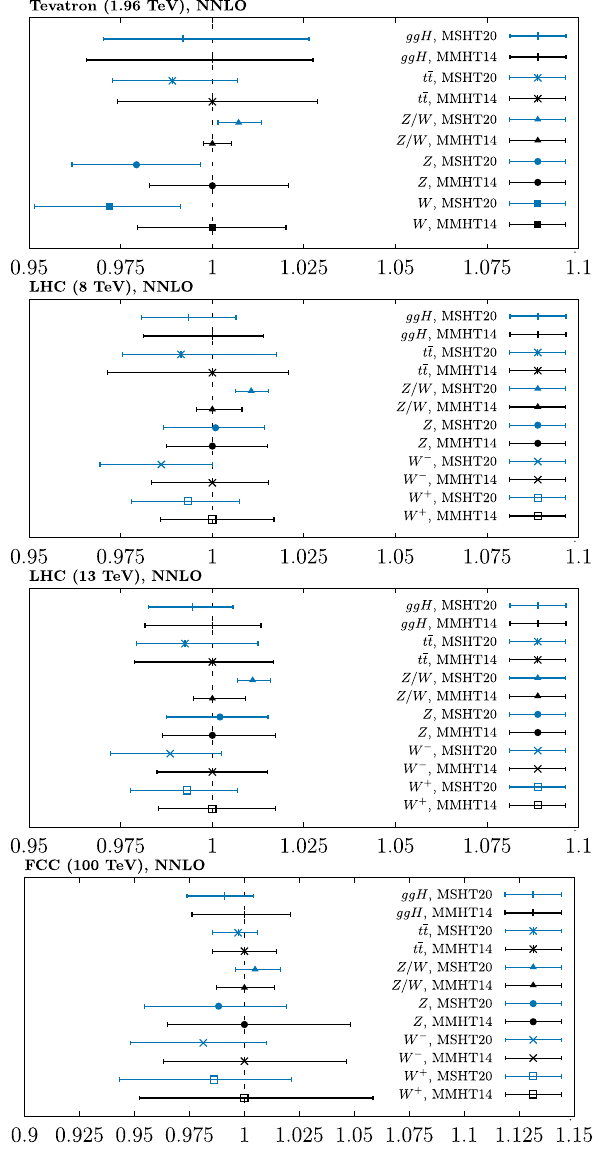
Fig. 82 Benchmark cross sections obtained with the NNLO MMHT14 [1] and the NNLO MSHT20 PDFs. Results are normalized to the central value of the MMHT14 prediction, and PDF uncertainties only are shown